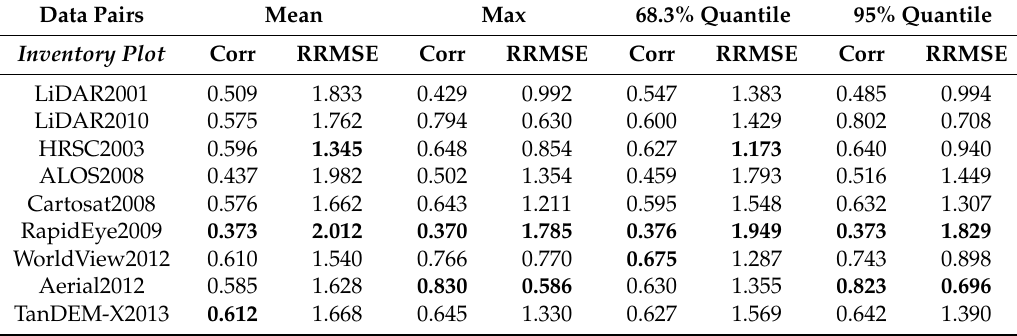
Figure 6. Comparison of canopy height metrics from LiDAR2001 ( a ), LiDAR2010 ( b ), HRSC2003 ( c ) ALOS2008 ( d ), Cartosat2008 ( e ), RapidEye2009 ( f ), WorldView2012 ( g ), Aerial2012 ( h ) and TanDEM-X2013 ( i )with the H100 heights derived from forest inventory plots ( n = 184). Table 4. Correlation coefficients between DSM metrics and with the H100 height of forest inventory plots and RRMSE by taking H100 from 2008 and from 2013 as reference (the best and worst results are marked in bold).